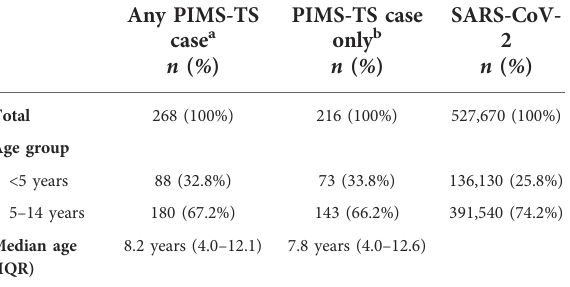
TABLE 1 Summary statistics of the PIMS-TS and SARS-CoV-2 datasets used to estimate PIMS-TS parameters during the fi rst wave of the COVID-19 pandemic in